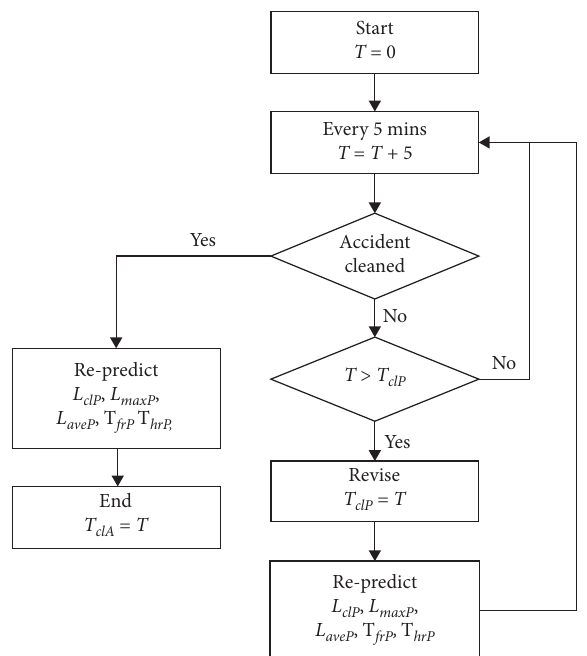
Figure 10: Error detection and adaptation